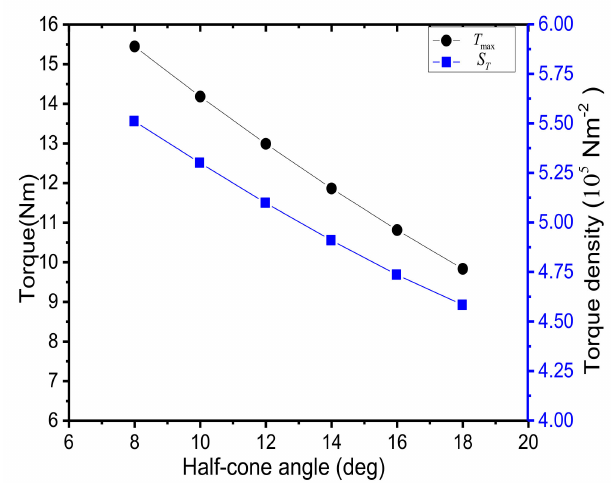
Figure 11. T max and S T versus half-cone angle.